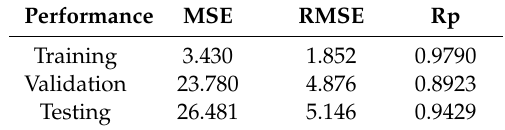
Table 11. Performance of the ANN model for the dry season.